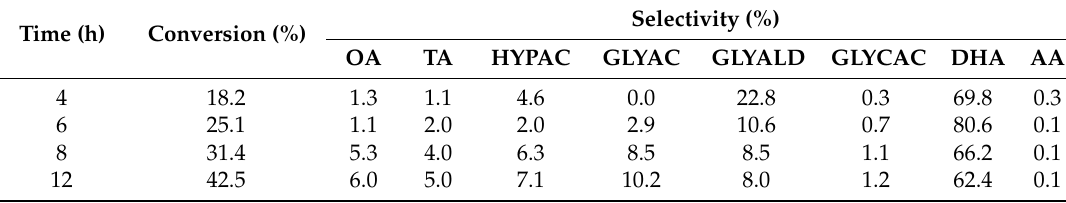
Table 3. Catalytic reaction results on Pt–Bi/HT catalysts at various reaction times a